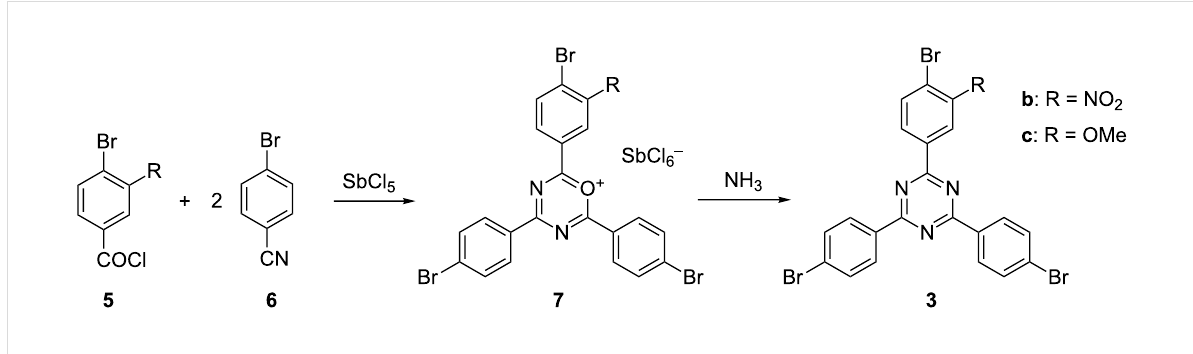
Figure 4: Synthesis of unsymmetrically substituted 2,4,6-tris(bromoaryl)-1,3,5-triazines 3 from one equivalent of a substituted benzoyl chloride 5 and two equivalents of benzonitrile 6 . As intermediates, oxadiazinium salts 7 are formed. The reaction with ammonia yields the desired triazines 3 (overall yields: 53% ( 3b ), 61% ( 3c